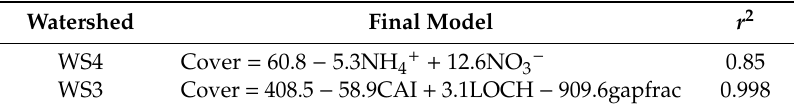
Table 2. Backward stepwise regression for study watershed at Fernow Experimental Forest, WV, beginning with the following initial model: cover = moist + NH 4 + + NO 3 − + N min + nit + CAI + LOCH + gapfrac + rug, where cover is percent herb layer cover, moist is soil moisture, NH extractable soil N, NO 3 − is extractable soil N, N min is net N mineralization, nit is net nitrification, CAI is canopy area index, LOCH is local outer canopy height, gapfrac is gap fraction, and rug is rugosity. See Methods for explanation of canopy structural variables, stepwise regression procedure, and units for independent